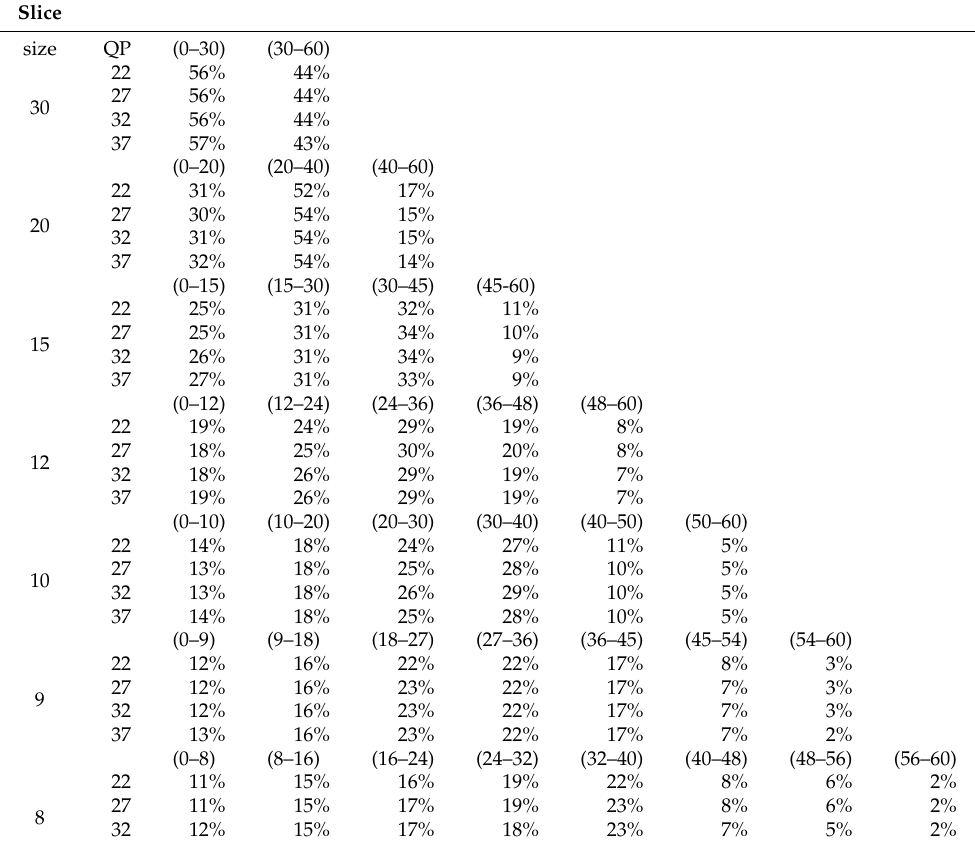
Table 8. Computational cost per slice for Four People video sequence.